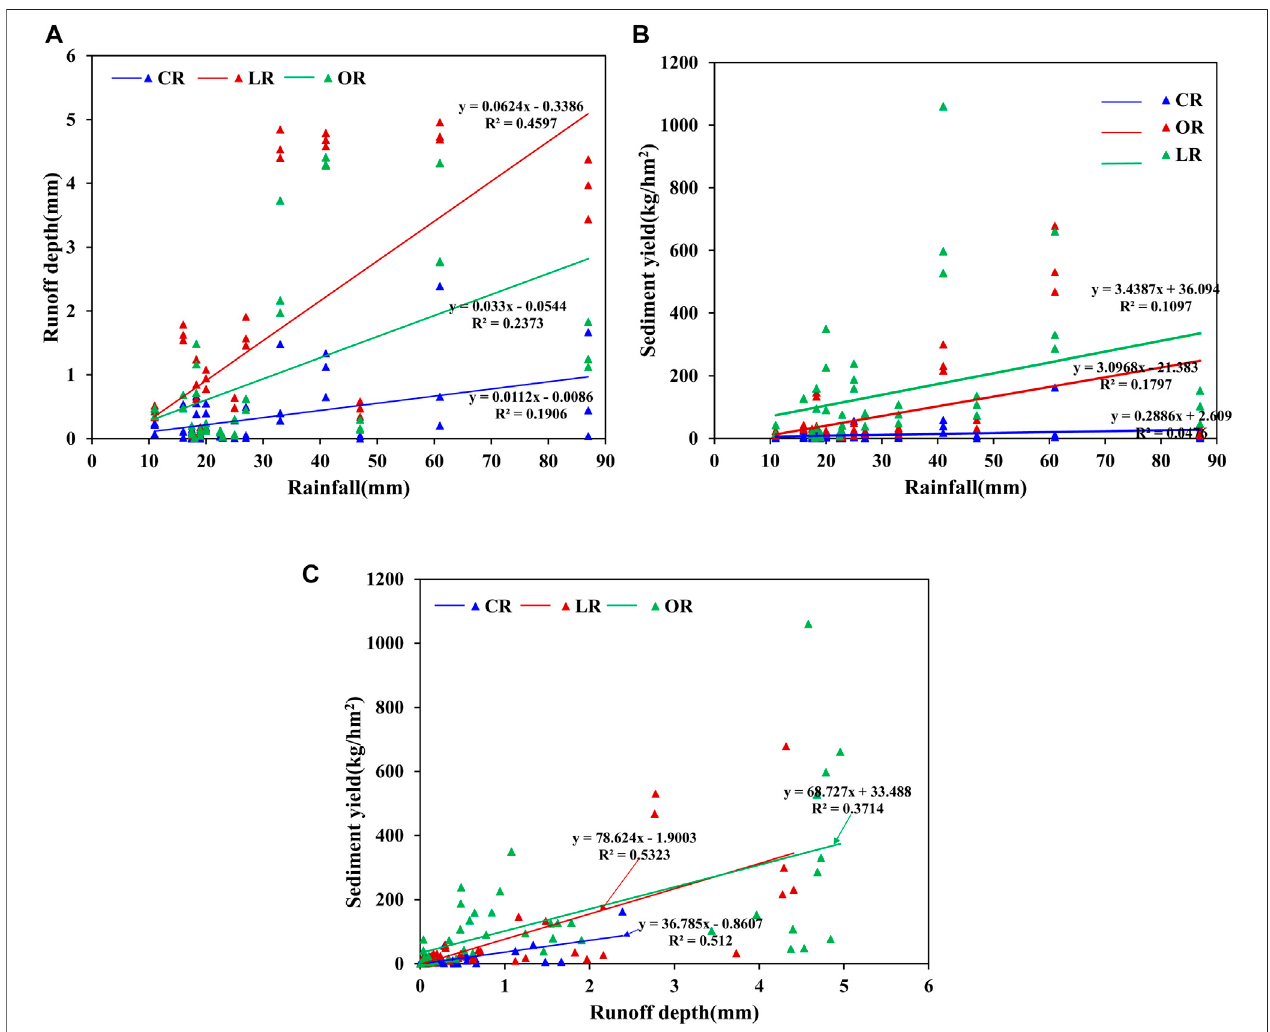
FIGURE 9 | Linear regressions of rainfall, the runoff depth, and sediment yield under CR (cross-ridge tillage), OR (oblique-ridge tillage), and LR (longitudinal-ridge tillage). (A) Rainfall and the runoff depth, (B) rainfall and sediment yield, and (C) the runoff depth and sediment yield.